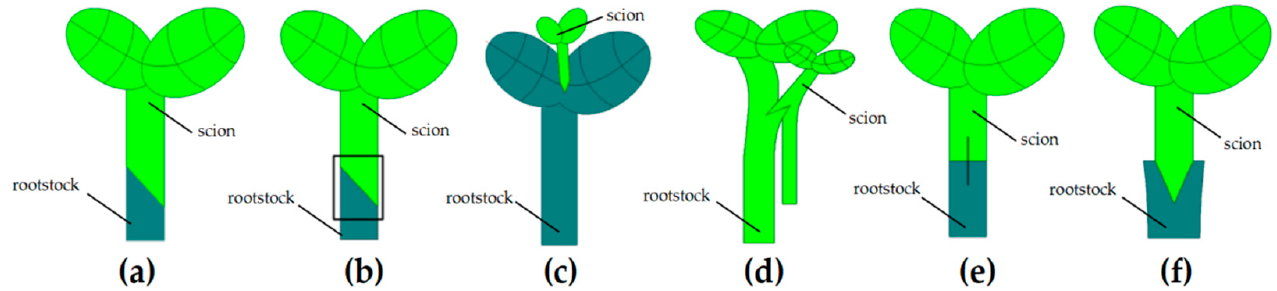
Figure 1. Common grafting methods for vegetables. ( a ) Splice grafting; ( b ) Tube grafting; ( c ) Insertion grafting; ( d ) Approach grafting; ( e ) Pin grafting; ( f ) Cleft grafting.